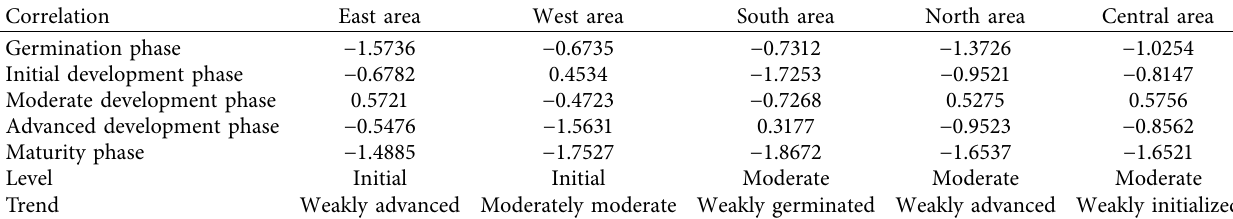
Table 2: Evaluated level of real economic development in each subarea.